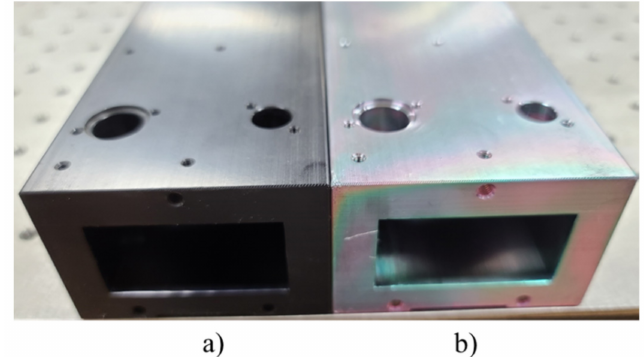
Figure 3. Aluminum-anodized gas chamber ( a ) and aluminum-Silcotek ® coated gas chamber ( b ) used in this study and captured by